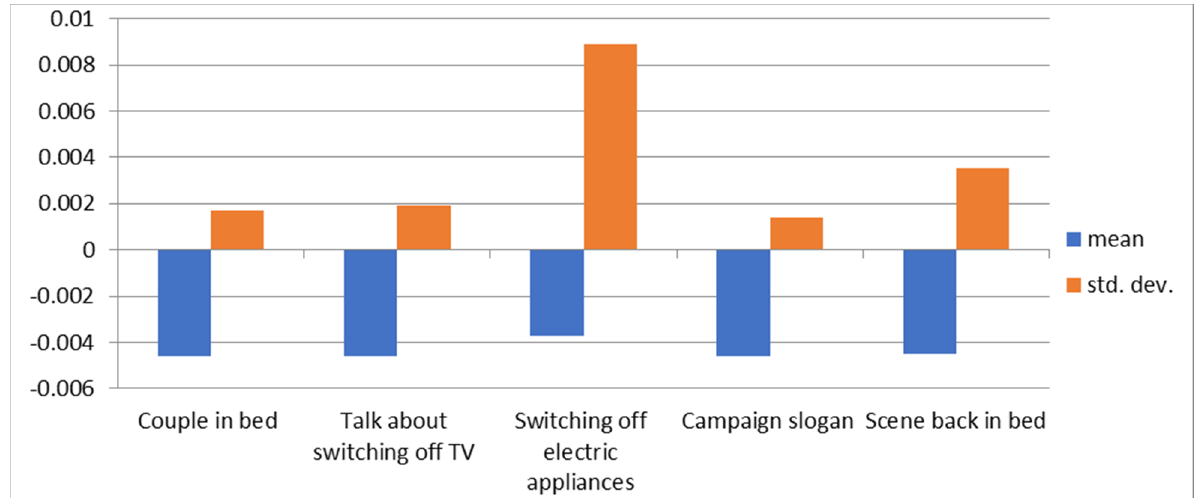
Figure 5. Average values and standard deviations of the normalized index of engagement for the “turn off power, turn on savings” media message.